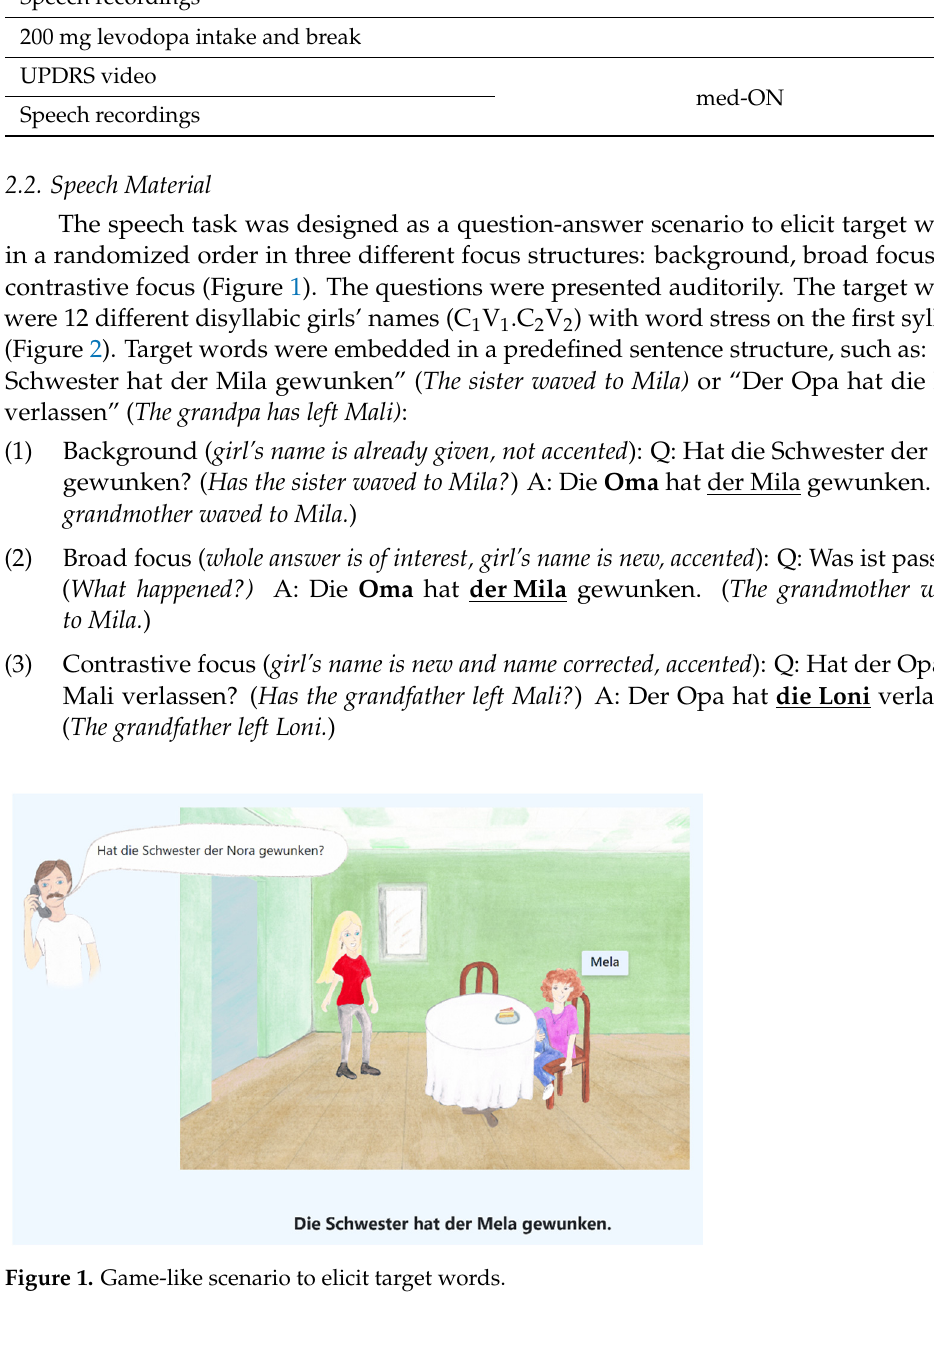
Table 2. Procedure of the experiment.